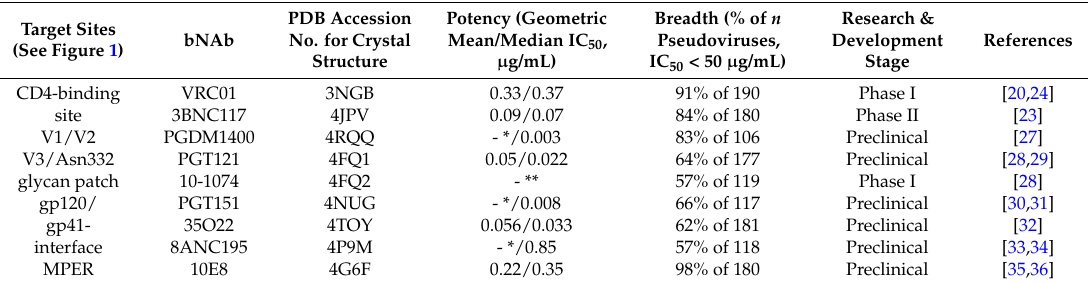
Table 1. Characteristics of the representative broadly neutralizing antibodies (bNAbs) summarized in this